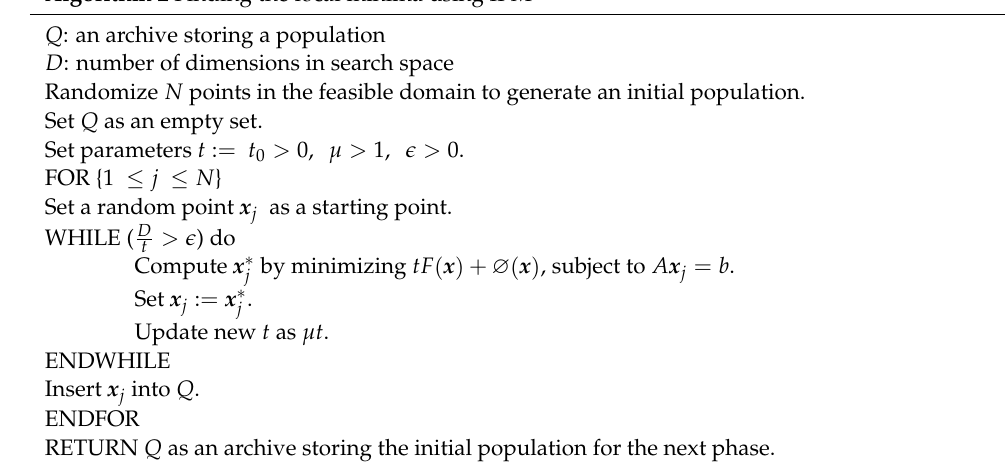
Algorithm 2 Finding the local minima using